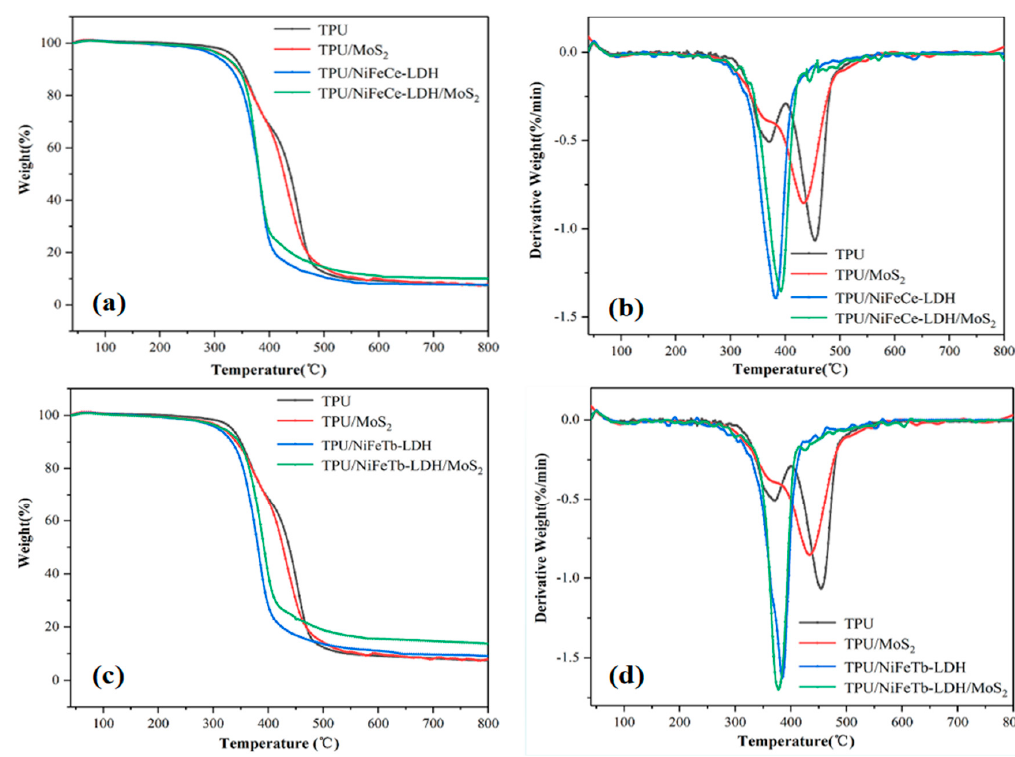
Figure 10. TG ( a,c )and DTG ( b,d ) curves of TPU and TPU composites. Table 2. Thermogravimetry data of TPU composites.